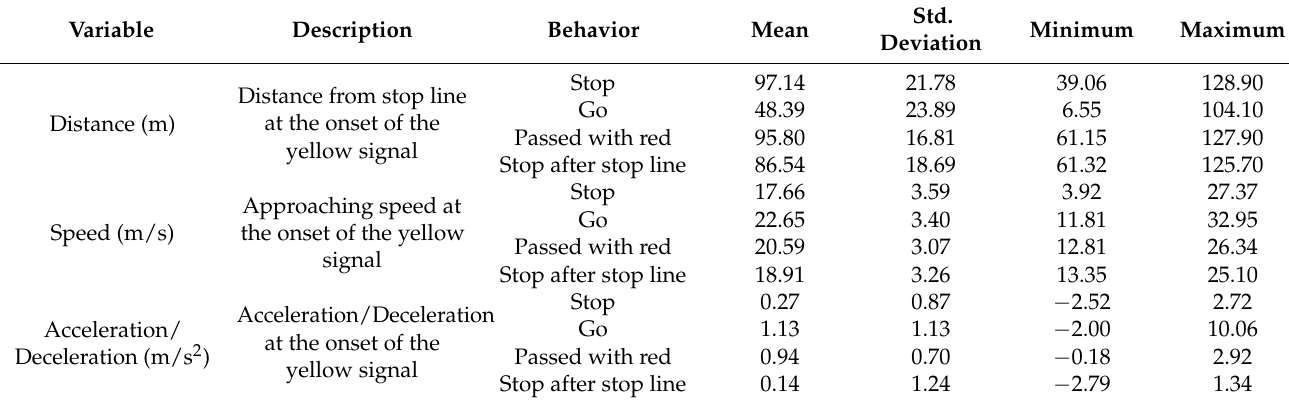
Table 3. Descriptive statistics of main variables based on drivers’